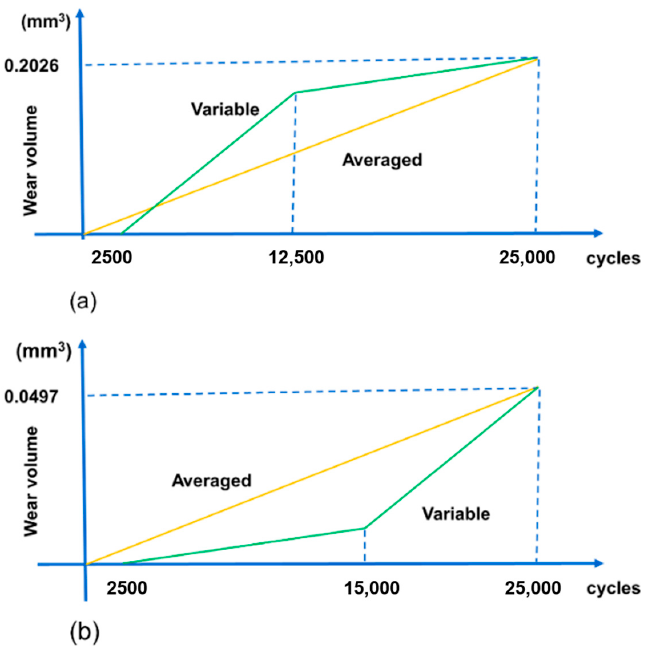
Figure 13. Profiles of the cylinder before and after fretting wear and the adjusted wear profile.